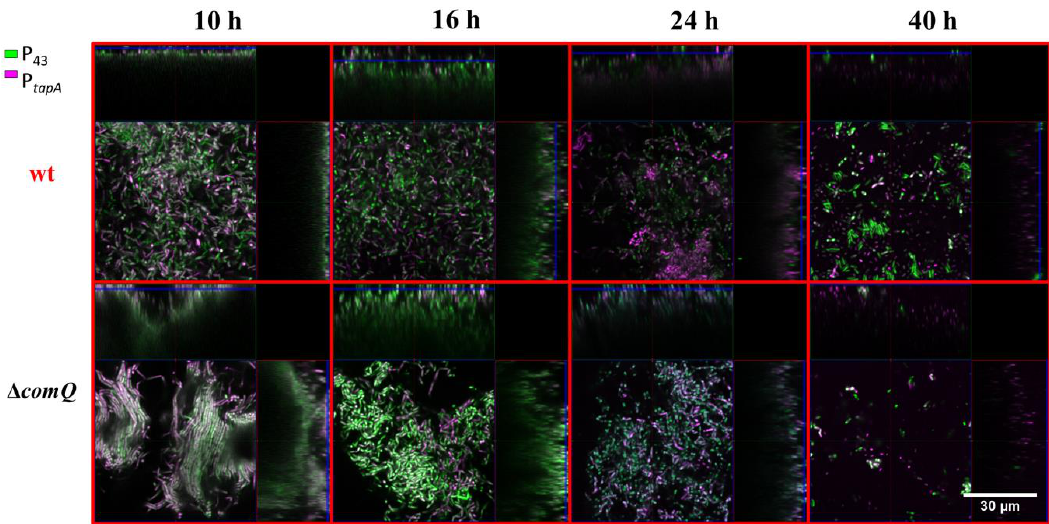
Figure 4. Pellicle biofilms of the PS-216 Bacillus subtilis wild type (wt; BM1613) and the QS mutant ( Δ comQ; BM1614) phenotypes carrying P 43 - mKate2 (false-colored green) and P tapA -y fp (false-colored magenta) transcriptional reporters during static growth in MSgg medium at 37 ◦ C and visualized under a confocal microscope at the indicated time